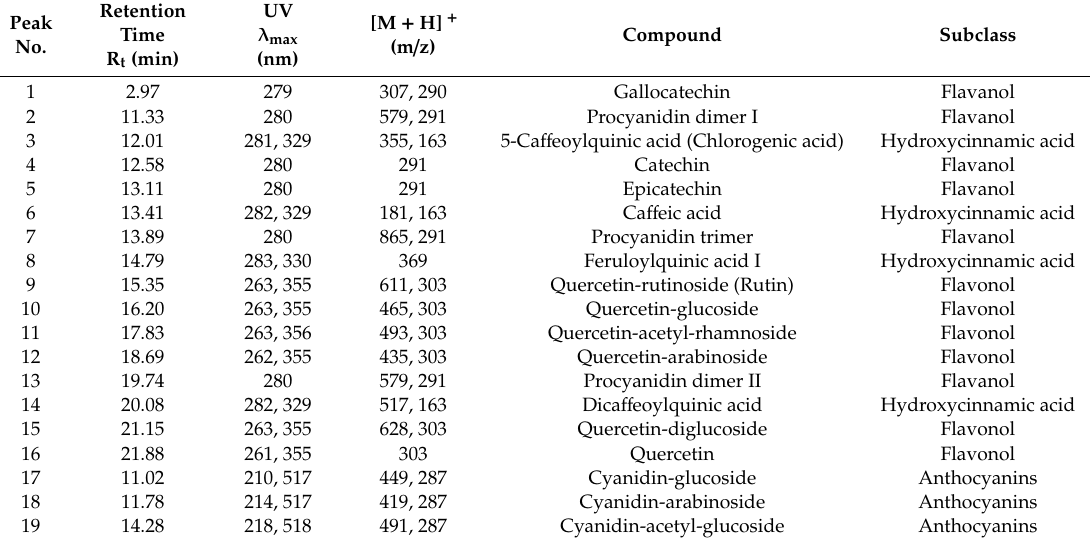
Table 1. Identification of the phenolic compounds from the flavonoid class (flavanols, flavonols, and anthocyanins) and hydroxycinnamic acids class in the leaf extracts of the blueberry varieties. Peak